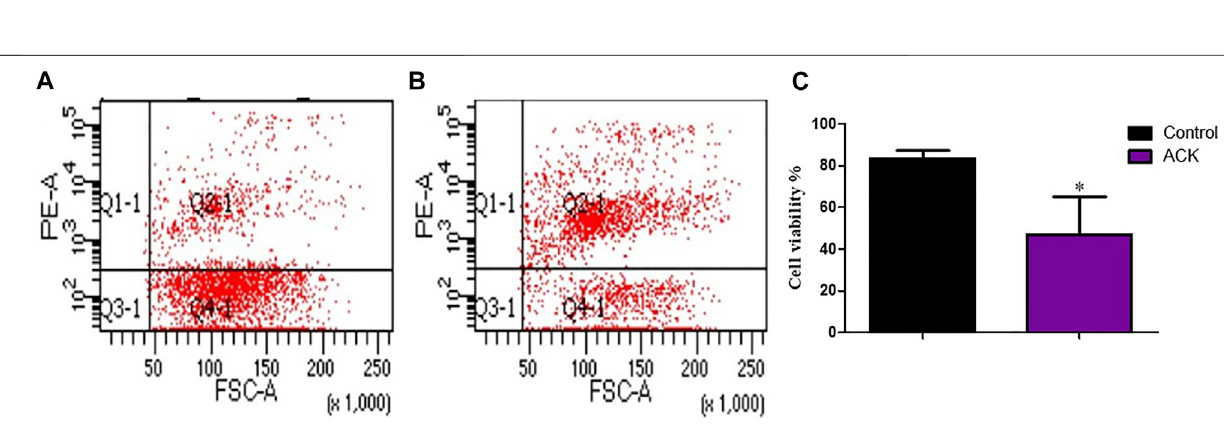
Frontiers in Cell and Developmental Biology |